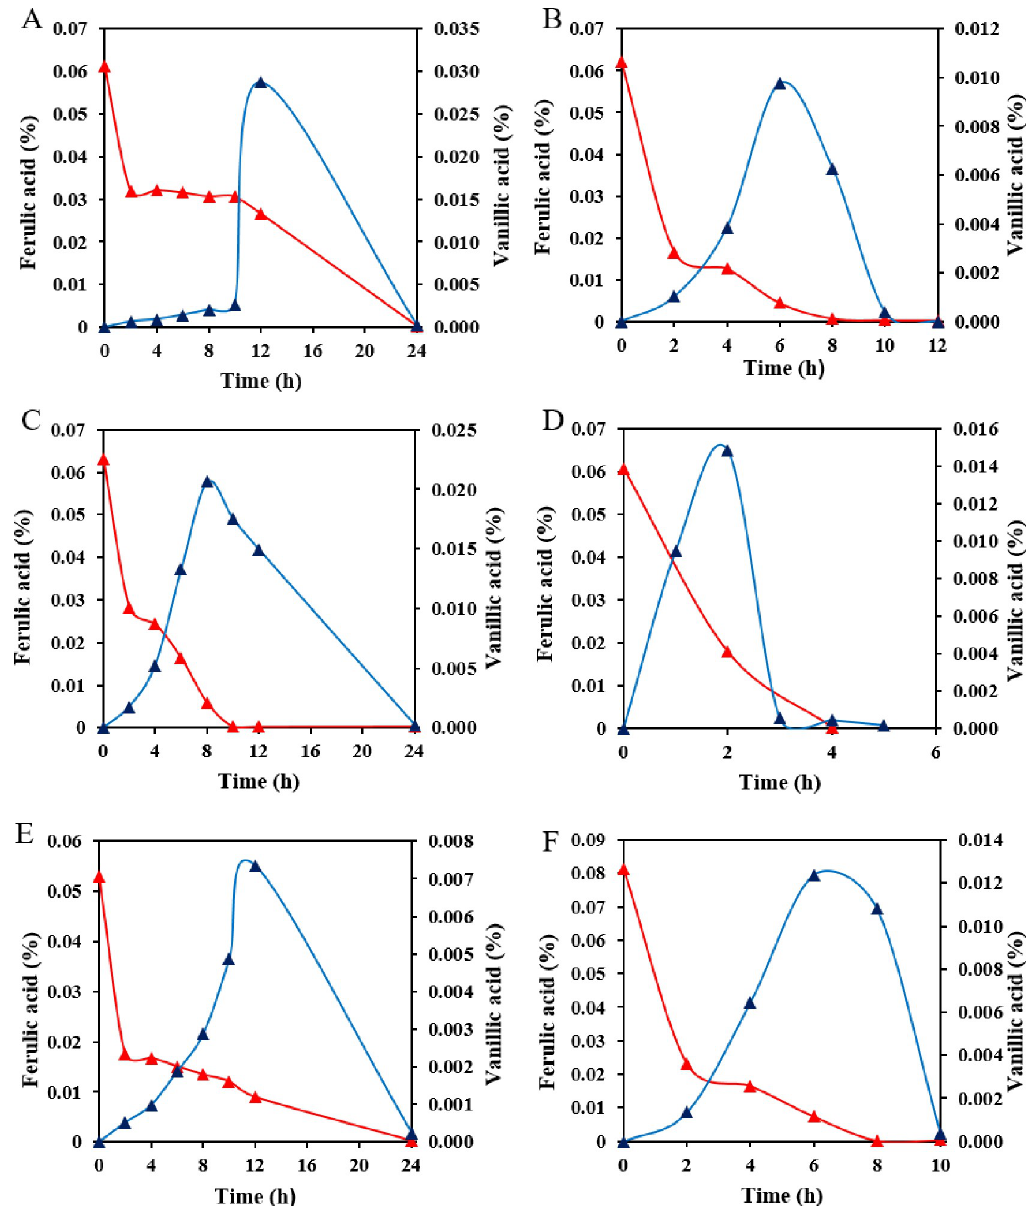
Fig 6. Metabolism of ferulic acid to vanillic acid by isolates ZXY12VA01 (A), ZXY12VA05 (B), ZXY12VA14 (C), ZXY12VA15 (D), ZXY12VA16 (E), ZXY12VA17 (F).